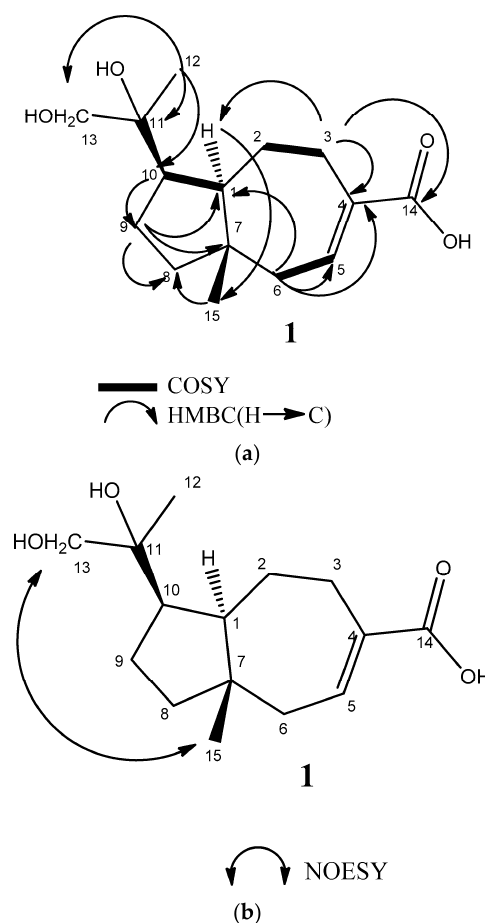
Figure 2. ( a ) Selected HMBC and 1 H– 1 H COSY spectra of compound 1 ; ( b ) selected NOESY spectrum of compound 1 . Table 1. 1 H- and 13 C-NMR spectral data of 1 and 2 (acetone- d 6 , 500 MHz).